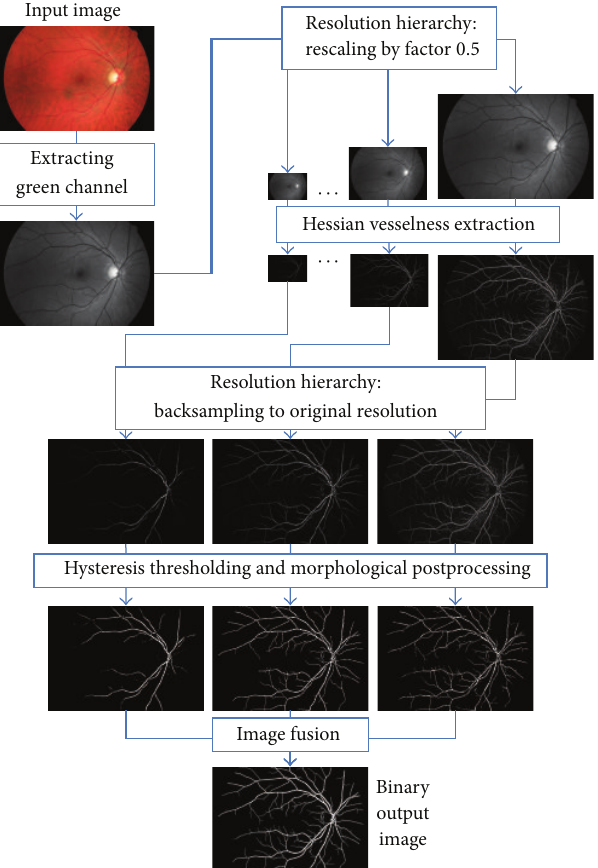
Figure 2: Pipeline of the proposed segmentation